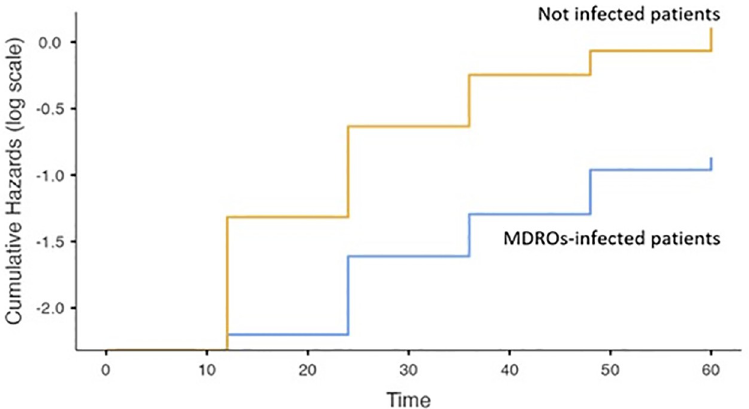
Fig 3. Survival cumulative Hazards between patients with MDROs infections and not infected. Yellow line: not infected patients, blue line: MDROs-infected patients.